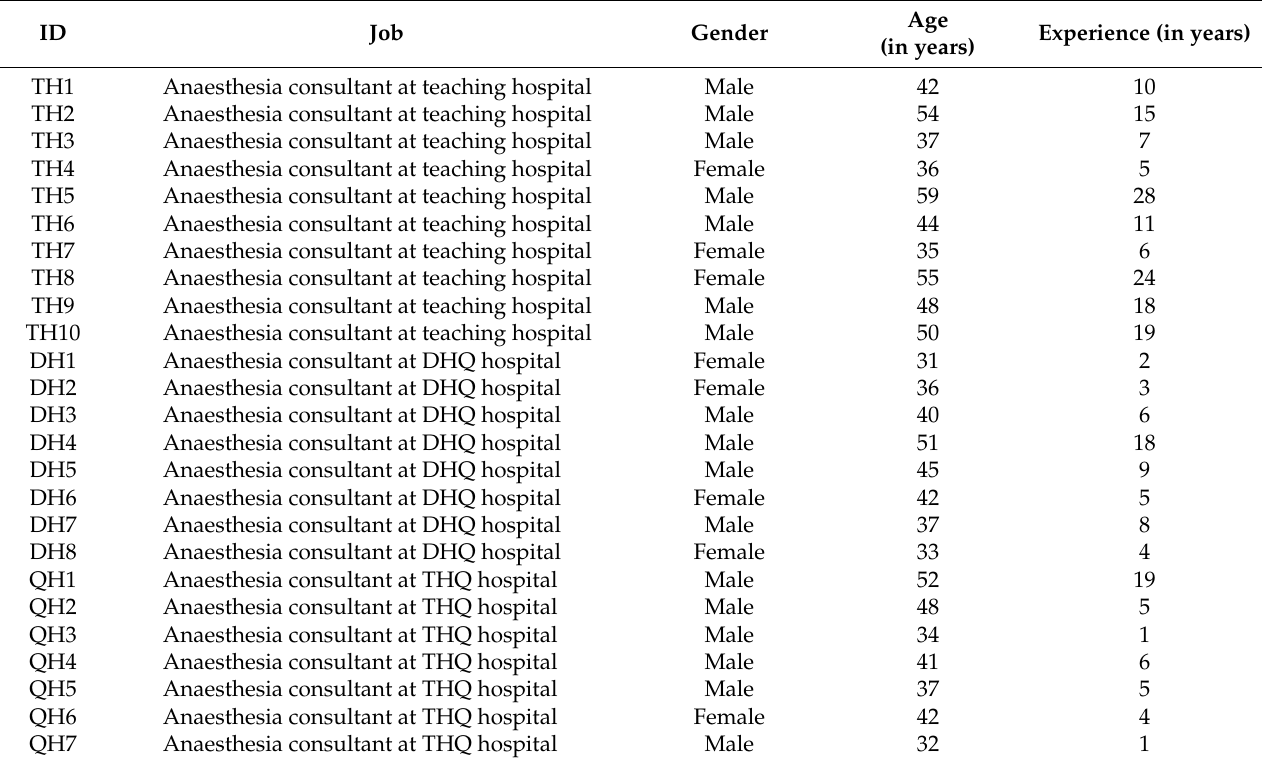
Table 1. Participants’